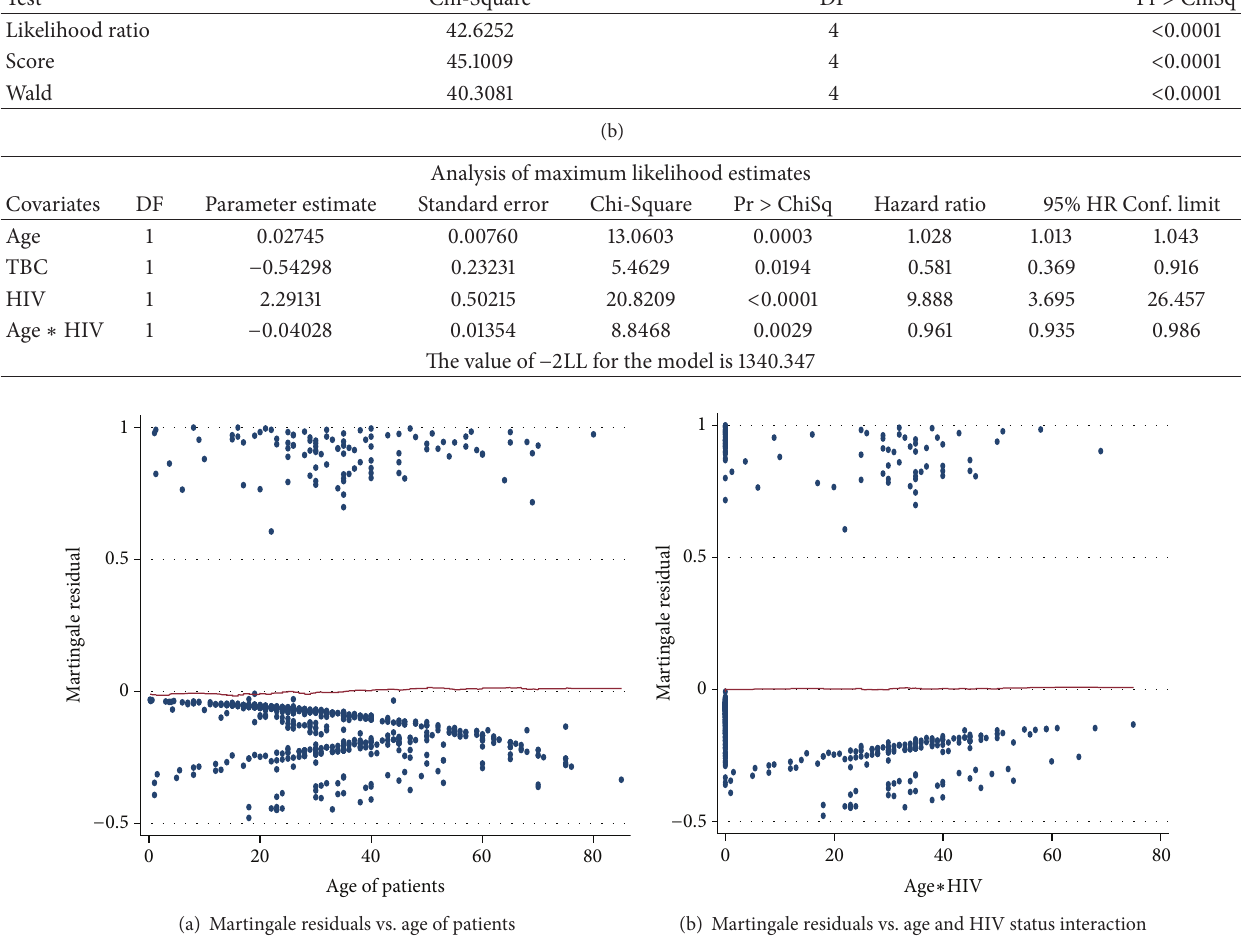
Figure 2: Plots of Martingale residuals computed for continuous covariates of TB patients under DOTS in AA health centers (a) age and (b) age and HIV status